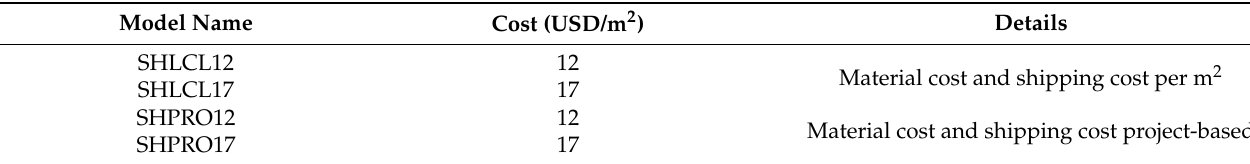
Table 6. Shipping models used in the